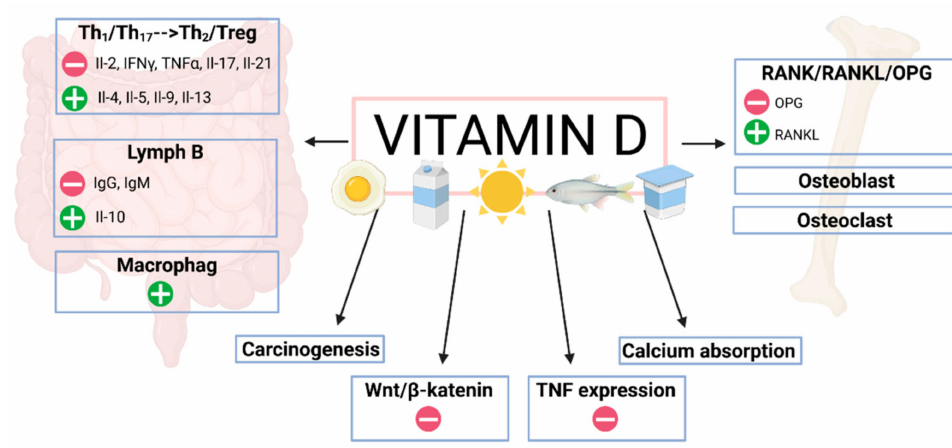
Figure 3. The mechanisms of vitamin D action on bone tissue in patients with